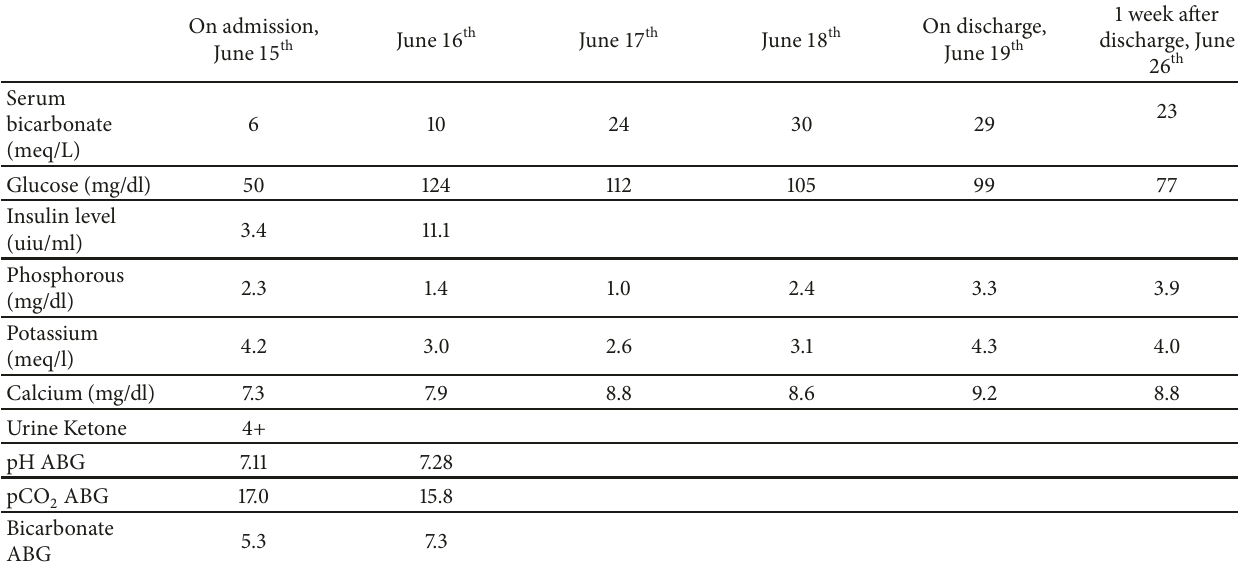
Table 2: Table demonstrating serial pertinent laboratory values during hospitalization and after